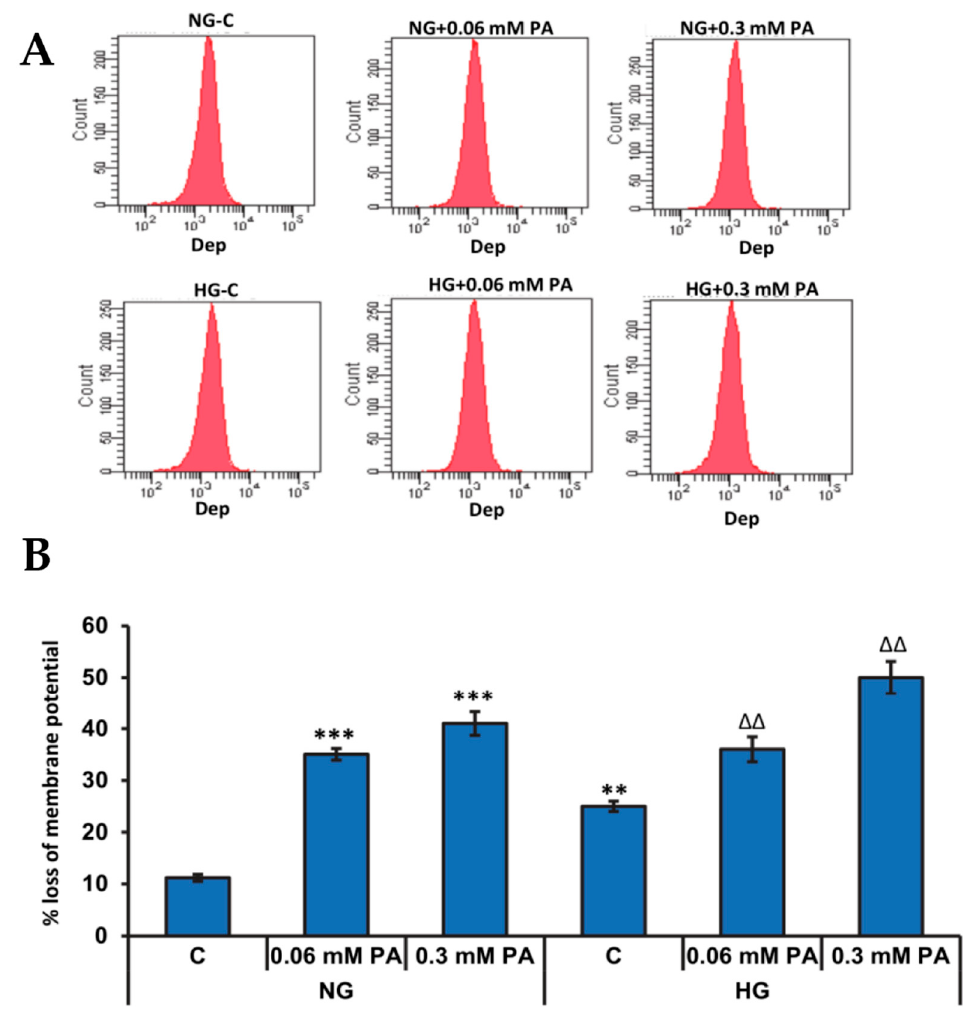
Figure 3. High glucose/high palmitic acid treatment induced alteration in the mitochondrial membrane potential. Mitochondrial membrane potential ( Δψ m) was measured by flow cytometry ( A ) using a fluorescent cationic dye according to the vendor’s protocol. A typical histogram ( B ) representing the percentage loss of mitochondrial membrane potential is shown. Results are expressed as mean +/ − SEM of three experiments. Asterisks indicate significant differences (** p ≤ 0.01, *** p ≤ 0.001) relative to untreated control cells under normal glucose condition (NG-C), and triangles indicate significant differences ( ΔΔ p ≤ 0.01) relative to untreated control cells under high glucose condition (HG-C).